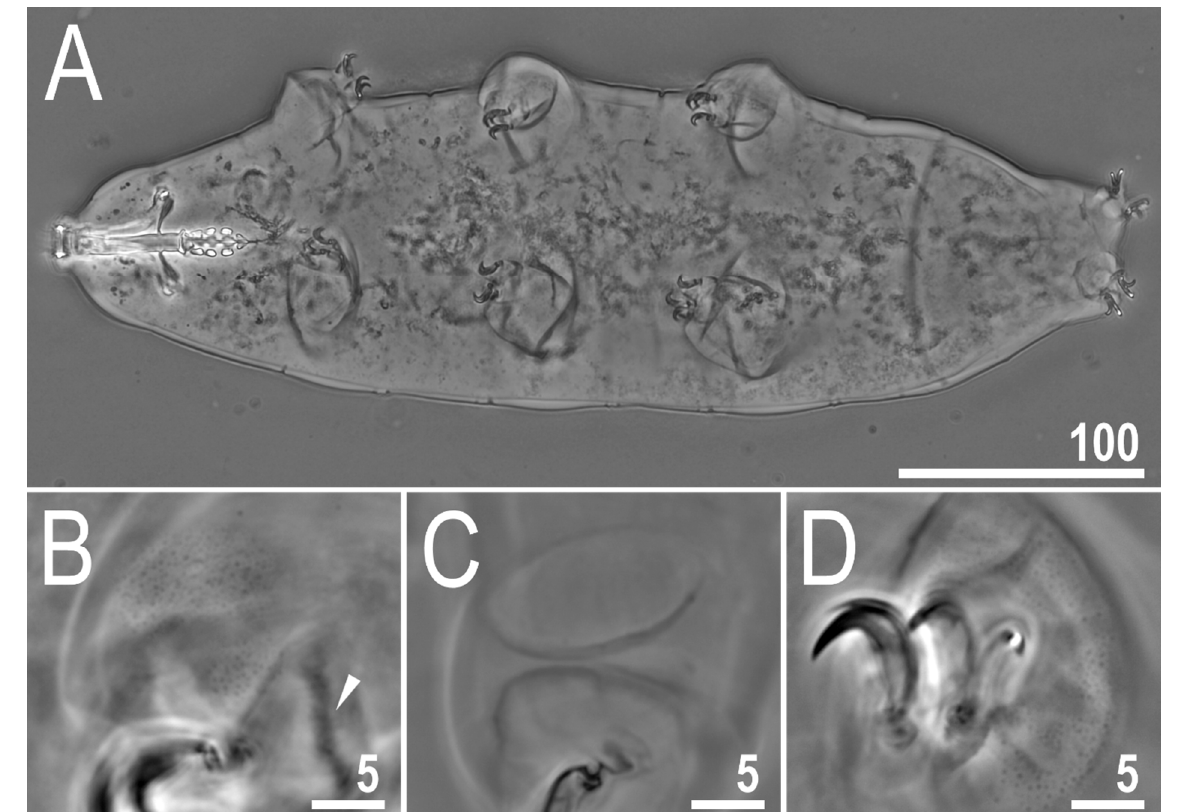
Figure 1. Mesobiotus imperialis sp. nov. —PCM image of habitus and leg’s cuticle morphology: ( A )—dorso-ventral projection (holotype); ( B )—granulation on the external surface of leg II (holotype); ( C )—a pulvinus-like cuticular bulge on the internal surface of leg III (paratype); ( D )—granulation on dorsal and lateral surface of leg IV (paratype). Filled flat arrowhead indicates a single continuous cuticular bar above the claws. Scale bar in μ m.